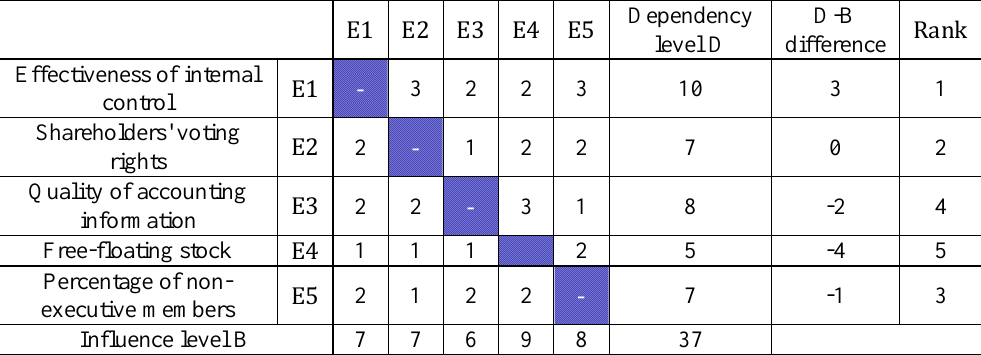
Dependency D-B level D difference